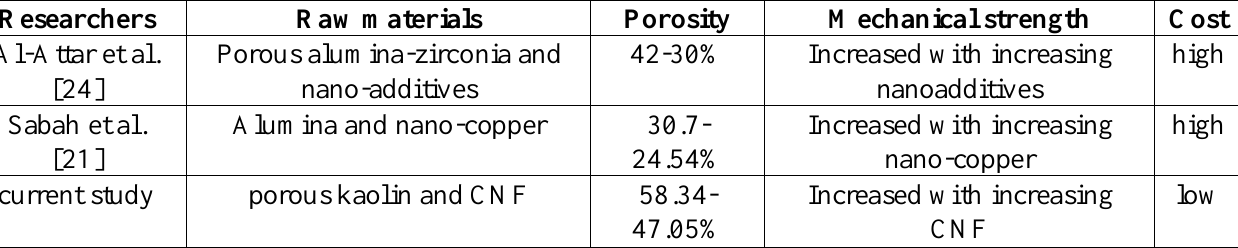
Figure 6: Effect of (CNF) ratios on the Porosity and diametrical Strength of specimens. Table 4: Comparison between the current study and previous